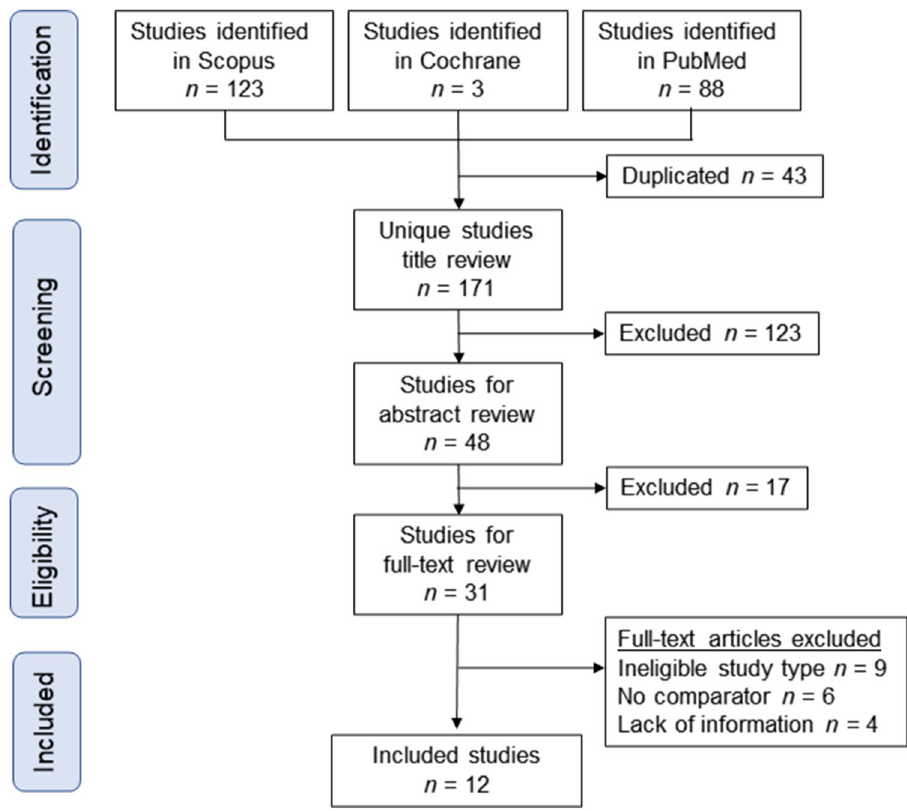
Figure 1. Study selection schema for the systematic review of the literature.